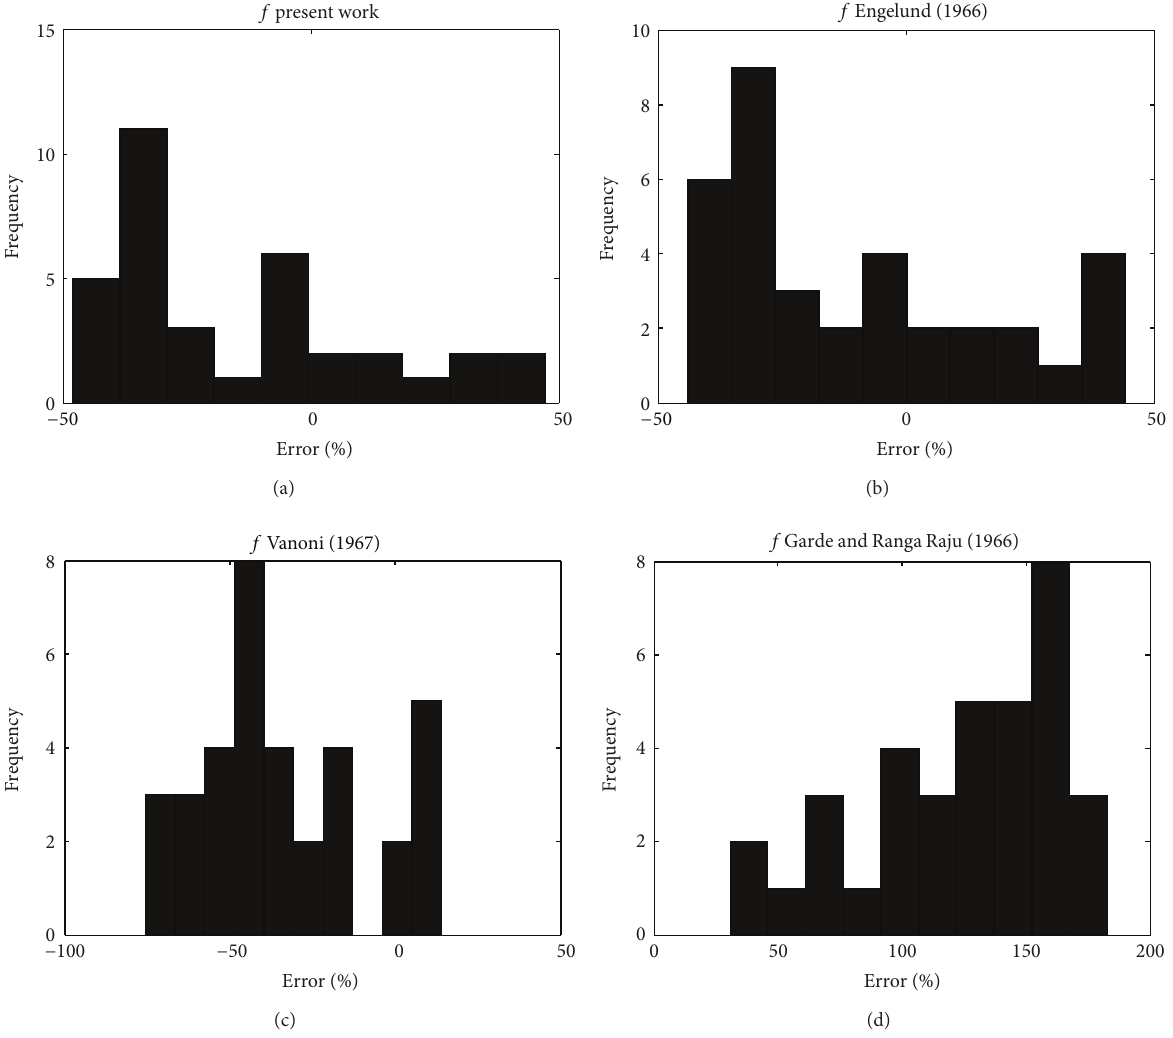
Figure 4: Histograms of percentage errors corresponding to the use of (10) and